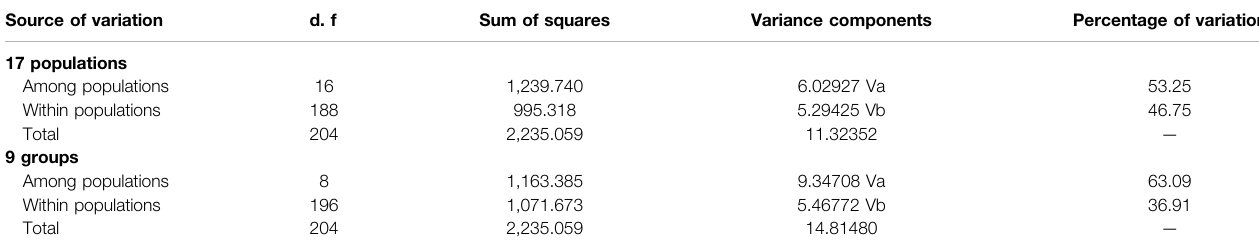
TABLE 5 | Analysis of molecular variance (AMOVA) based on combined genes.